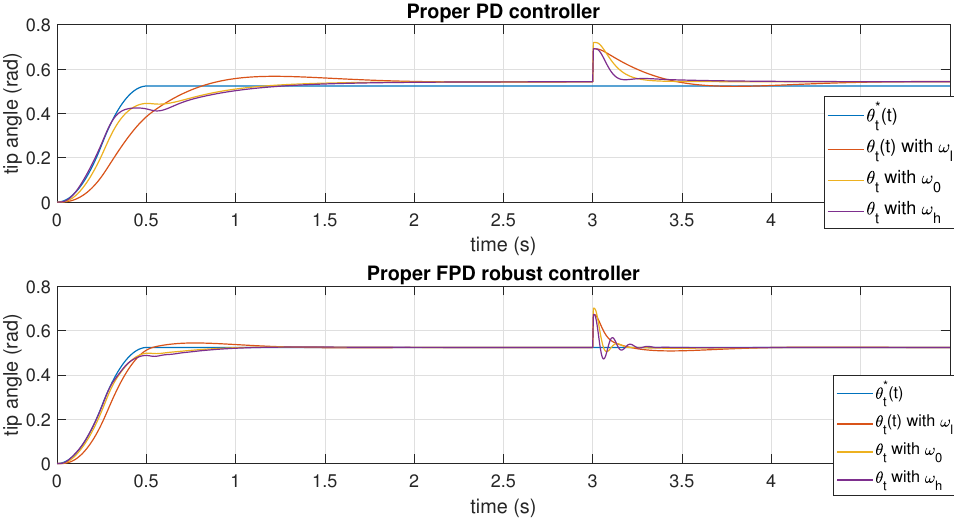
Figure 12. Simulated responses using controllers (44) and (45) for the minimum, nominal and maximum vibration